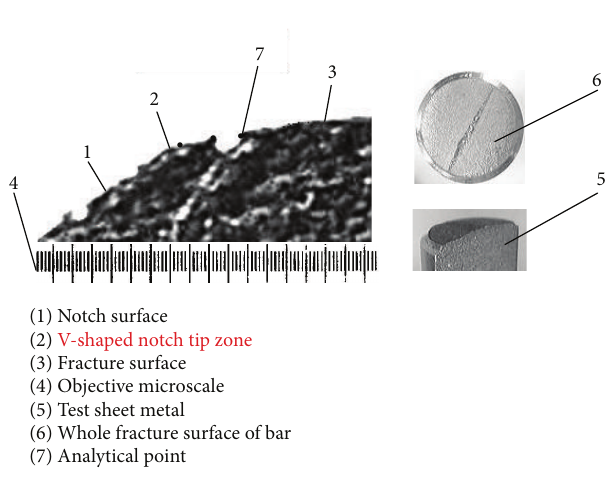
Figure 7: The microstructure near V-shape notch tip surface.